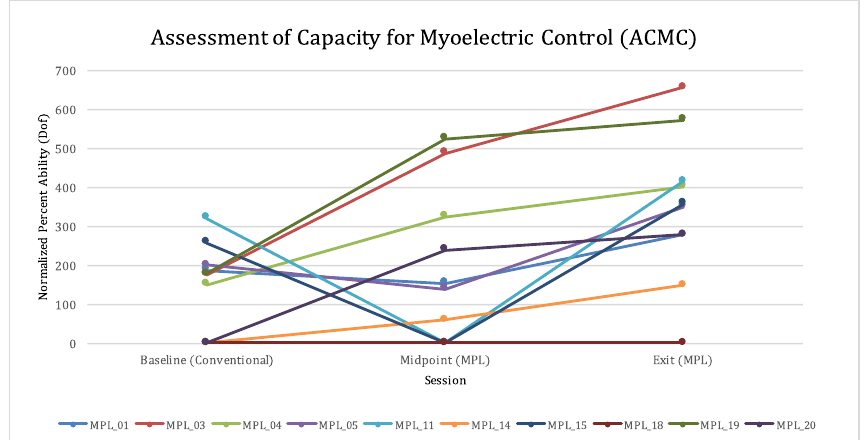
Figure 4. Assessment of Capacity for Myoelectric Control (ACMC) scores for each participant by percent ability, normalized to the number of DOF controlled during the